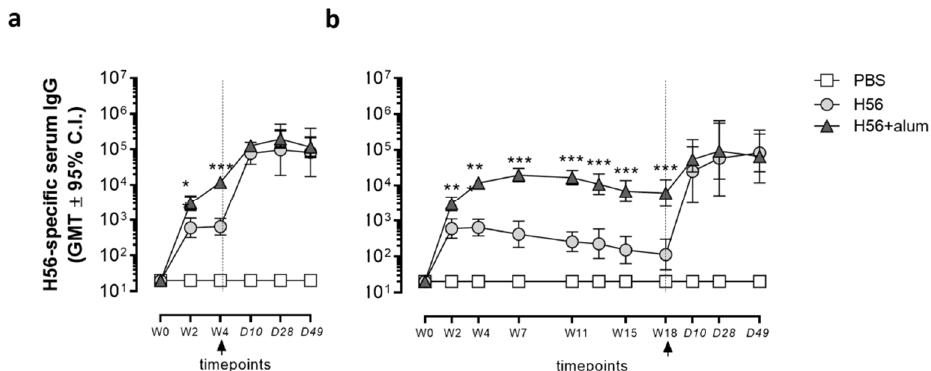
Figure 2. Antigen-specific IgG response. C57BL/6 mice were subcutaneously immunized, as summarized in Figure 1, and humoral response was analysed after the short ( a ) and long ( b ) immunization protocol. H56-specific IgG serum titers were analyzed 0, 2, 4, 7, 11, 15, 18 weeks following priming, and 10, 28, and 49 days after boosting by ELISA. Values are reported as GMT ± 95% CI of 12 mice from 2 different experiments. Antibody titers were expressed as the reciprocal of the dilution of the sample, reporting an optical density value double with respect to the background. The Mann–Whitney test for multiple pairwise comparisons was used for assessing statistical differences for each time point between groups. ** p ≤ 0.001; *** p ≤ 0.0001.